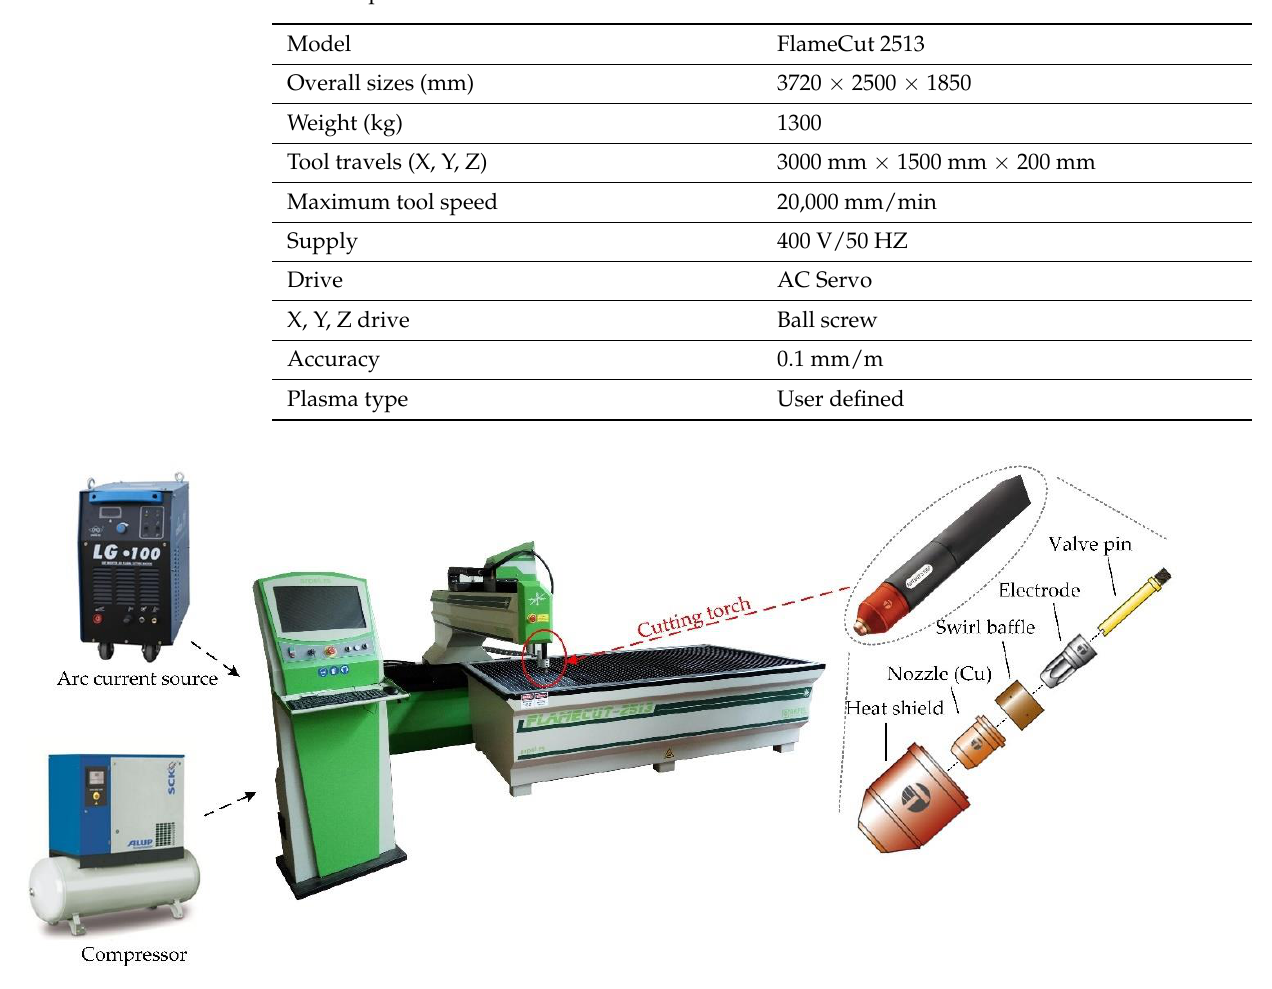
Figure 1. CNC machine FlameCut 2513, cutting torch, arc current source, and compressor. Table 3. Properties of aluminium EN AW-5083 H111. Chemical